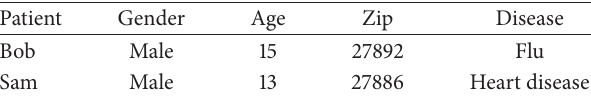
Table 1: Sample medical